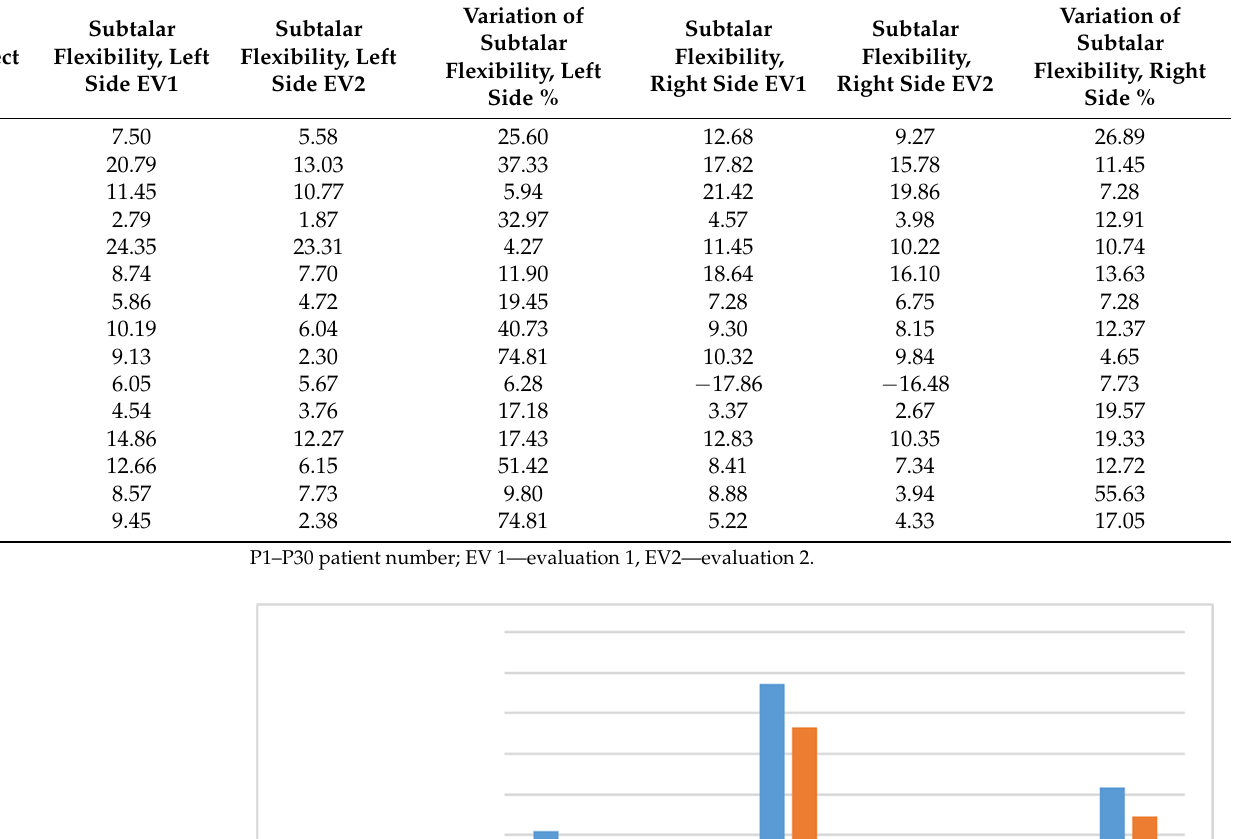
Table 1. Evolution of subtalar flexibility (Group 1, n = 15).